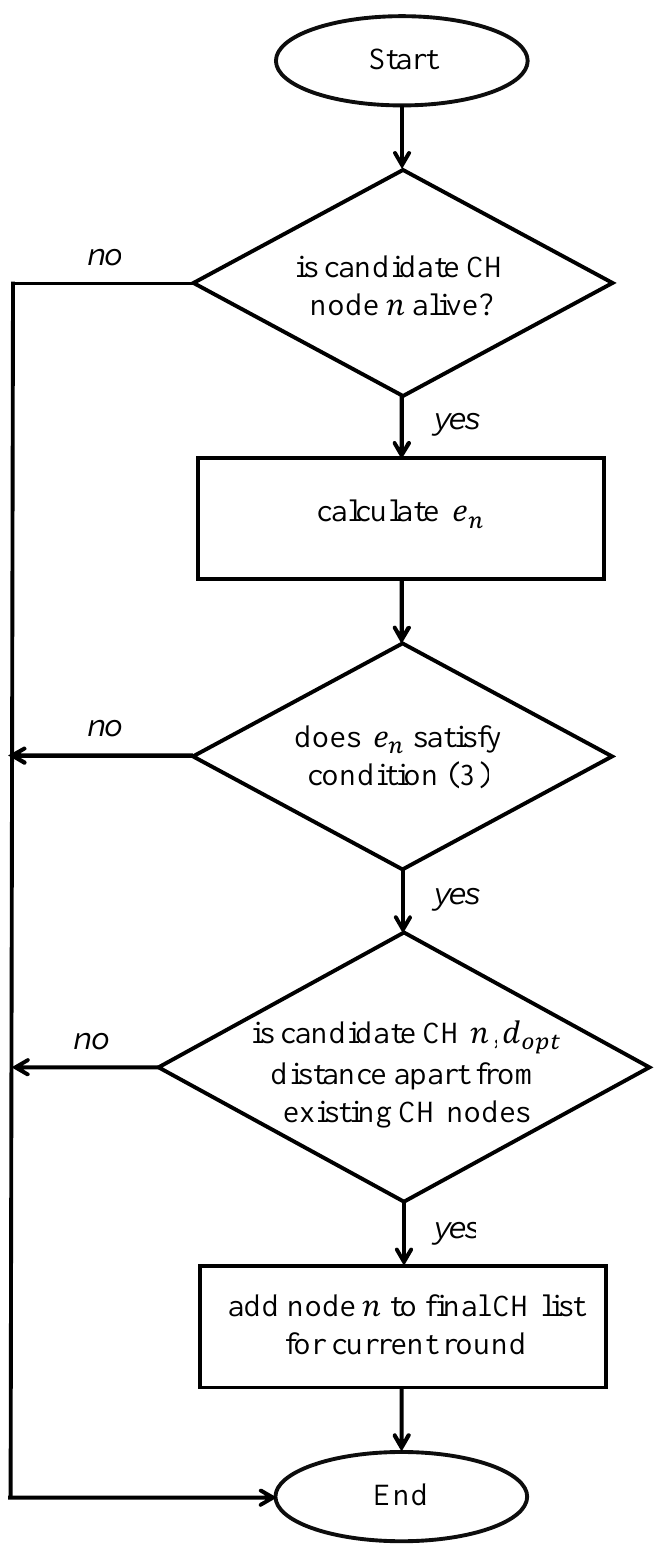
Figure 5. Cluster Head Selection Procedure of Energy and Optimal Inter Cluster Head Distance